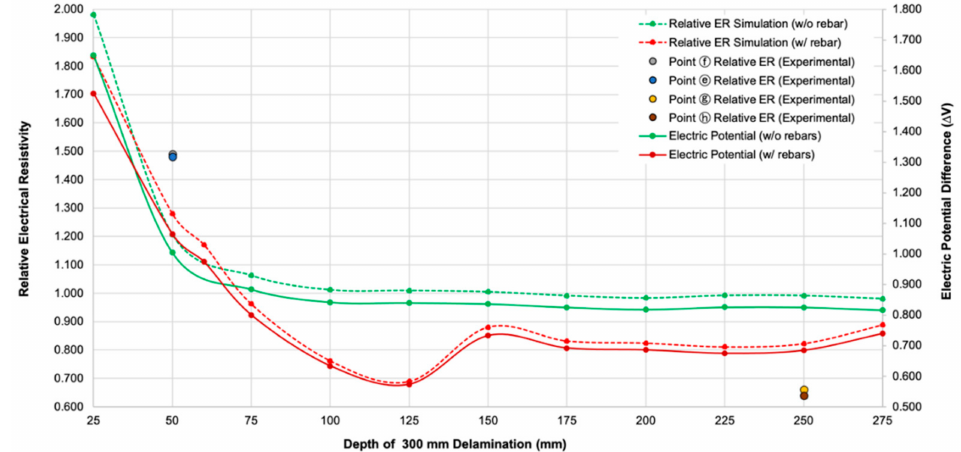
Figure 8. Variation of the electric potential di ff erence and relative electrical resistivity (ER) of concrete slab with depth of delamination defects measured from numerical simulation.